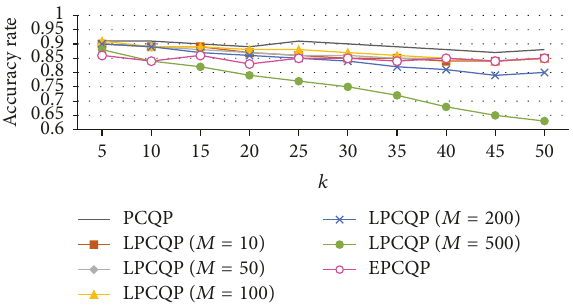
Figure 7: Query accuracy rate versus k of the real-world dataset.